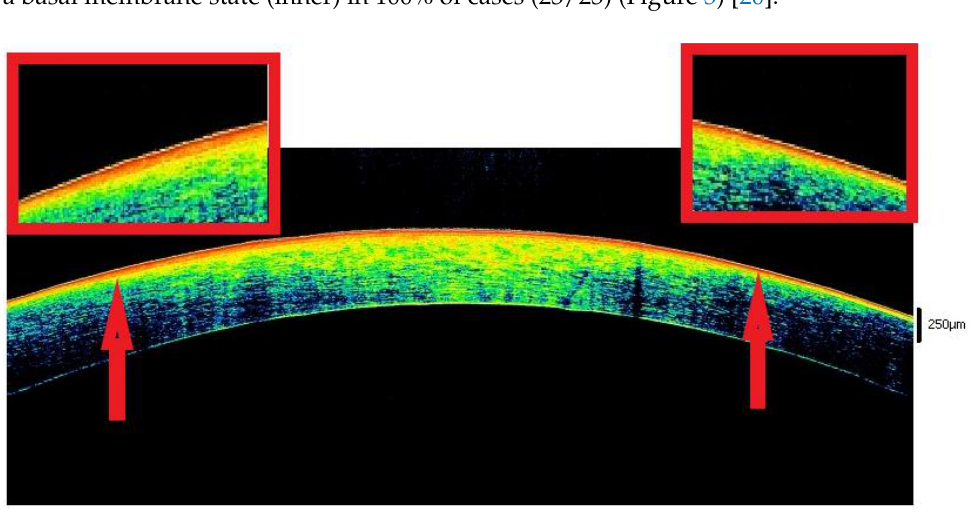
Figure 3. Binary sign. In open eyes, the phenomena of dehydration lead to the drying of the tear film (outer line of hyper-reflectivity). At the same time the appearance of hyper-reflectivity in the anterior surface of the cornea can be observed (inner line of hyper-reflectivity). These phenomena favor the formation of the typical “ binary ” pattern (indicated by red arrows) that characterizes all corneas exposed to the environment in the interval between the third and sixth hour. 3.2.2. The 6 – 9 h Interval In the interval from the 6th to the 9th hour, at the epithelial level, there was the dis- appearance of the previously described binary pattern. In all cases, the morphology of the